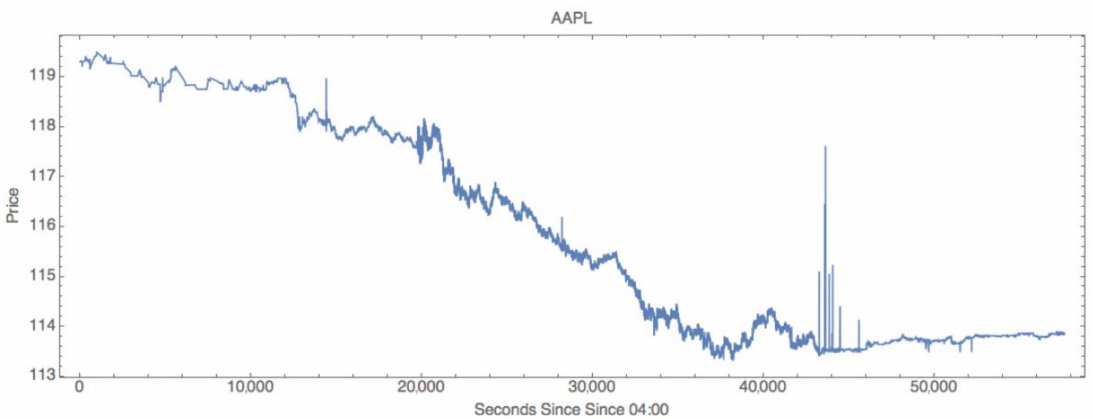
Figure 4. Apple stock price on 11 August 2015 at each second of the day from 04:00 until 20:00.